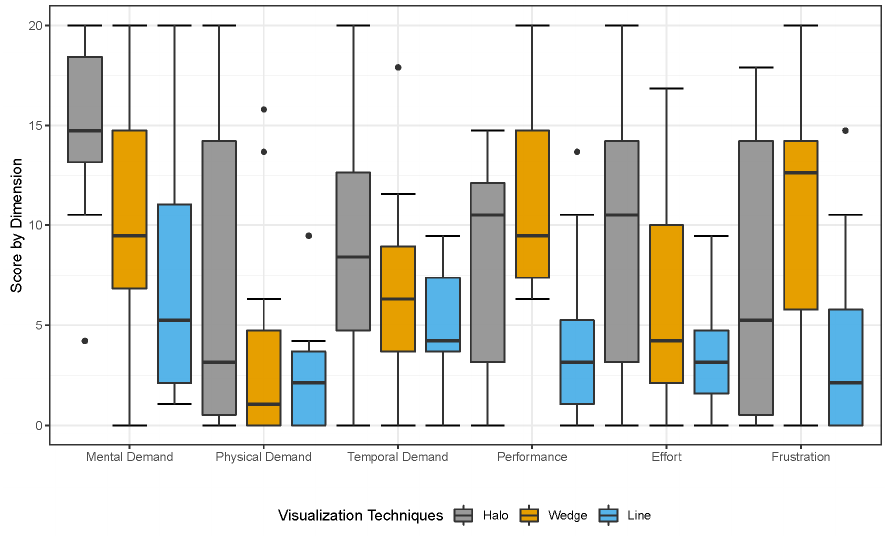
Figure 6. Comparison of the task load dimensions for the three different visualization techniques: Wedge ; Halo ; and Line